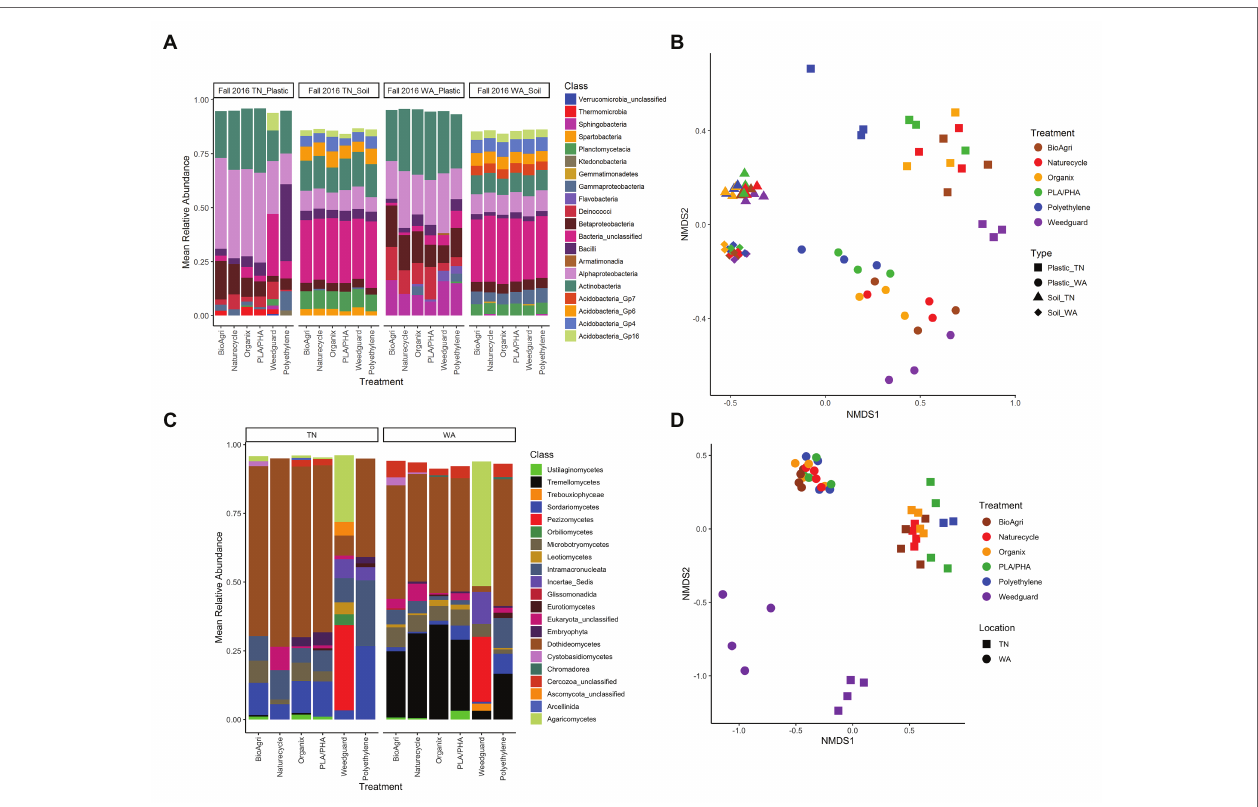
FIGURE 5 | (A) Bacterial taxa distribution (class level) on agriculturally-weathered plastics and bulk soil (Fall 2016) for TN and WA. Mean relative abundances above a cut-off level of 2% are indicated. “Bacteria unclassified” denote taxa with relative abundance above the cut-off level of 2%, but that could not be classified. (B) NMDS ordination of bacterial communities on agriculturally-weathered BDMs and bulk soil in TN and WA (Fall 2016). NMDS stress value: 0.12. (C) Eukaryotic taxa distribution (class level) on agriculturally-weathered plastics (Fall 2016) for TN and WA. Relative abundances above a cut-off level of 2% are indicated. “Eukaryota_unclassified” denote taxa with relative abundance above the cut-off level of 2%, but that could not be classified. Phylum level classification for class incertae_sedis was Mucoromycota for polyethylene, and Chytridiomycota for Weedguard. (D) NMDS ordination of eukaryotic communities on agriculturally- weathered BDMs in TN and WA (Fall 2016). NMDS stress value: